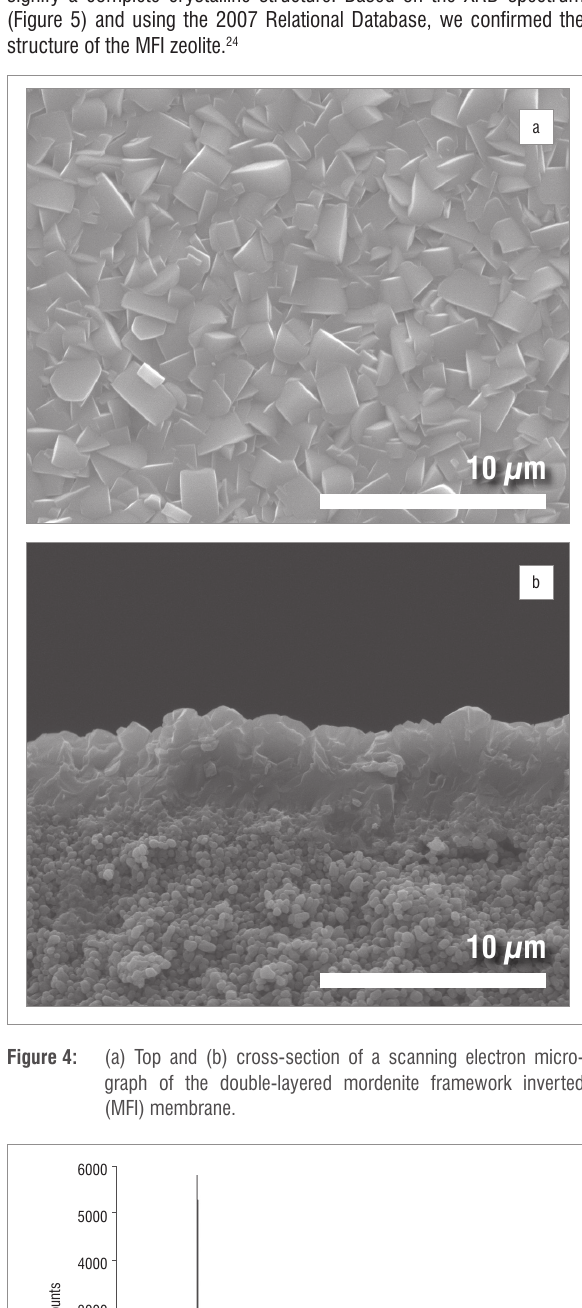
Figure 3: Cross-section through scanning electron micrographs near (a) the inner surface and (b) the outer surface of the α -alumina support.